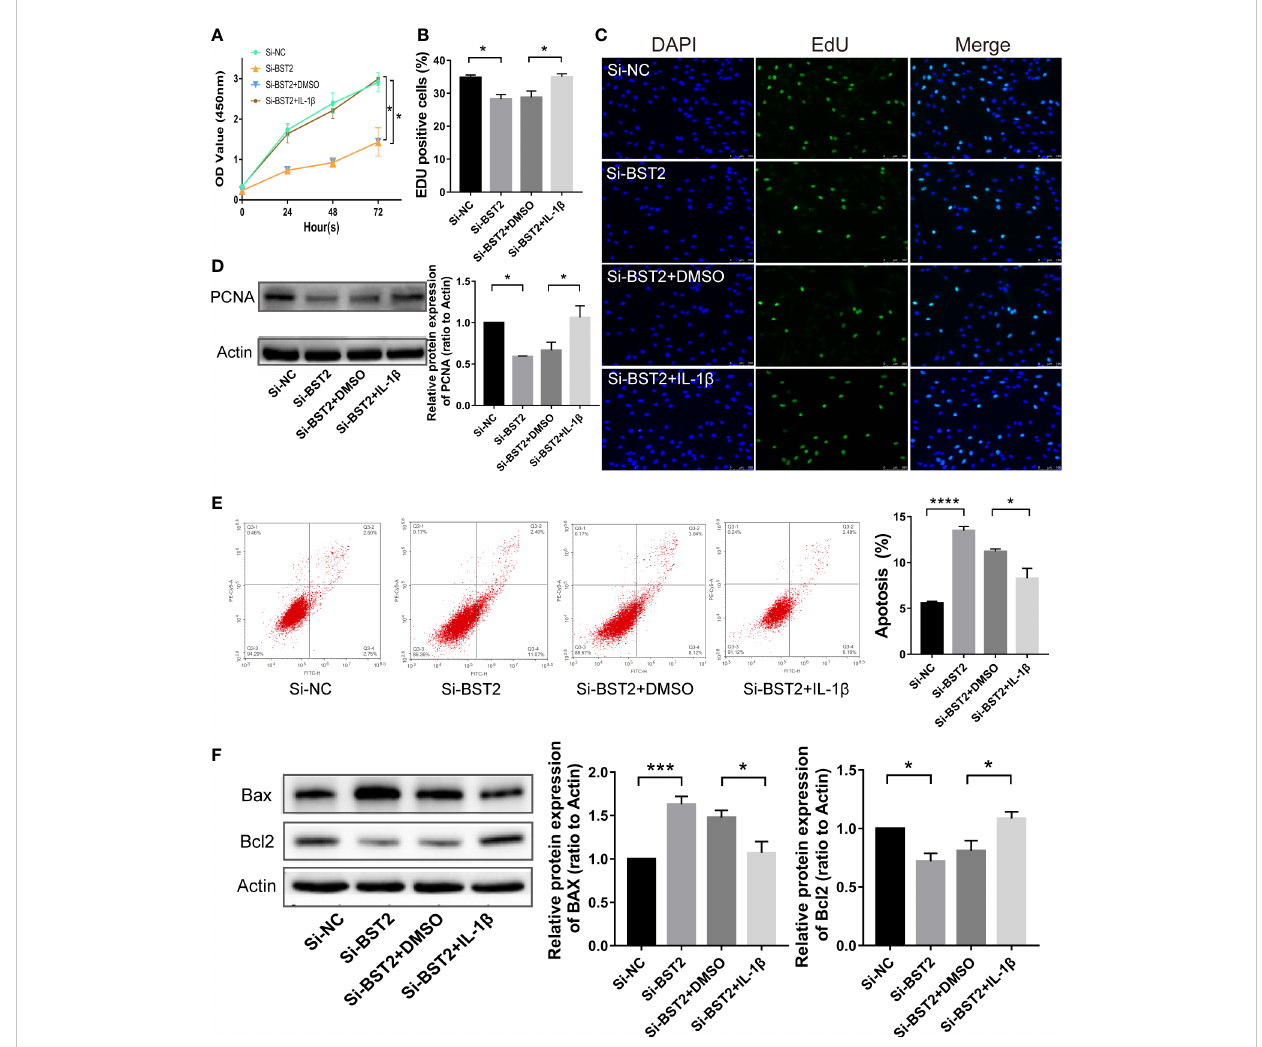
FIGURE 7 BST2 regulated proliferation and apoptosis of EESCs via the NF- k B signaling pathway. (A – C) , CCK-8 assay (A) and EdU staining assay (B, C) were conducted to measure the cell proliferation ability of EESCs after transfection with Si-BST2 and/or IL-1 b . (D, F) The western blot analysis was used to examine the proliferation-related protein (D) and apoptosis-related protein (F) after transfection with Si-BST2 and/or IL-1 b . (E) , The Flow cytometry was performed to detect the apoptosis rates of the EESCs transfected with Si-BST2 and/or IL-1 b . *p < 0.05; ***p < 0.001; ****p <